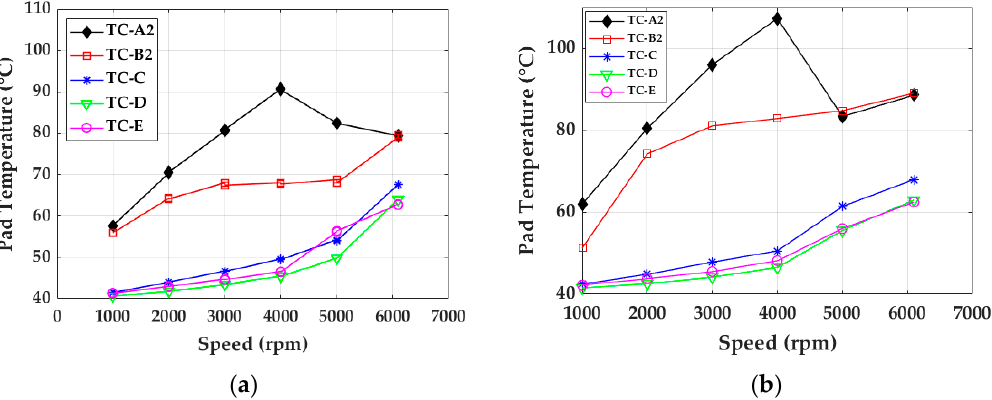
Figure 18. Flooded Rocker Pivot bearing pad temperatures @ 75% of pad arc: ( a ) 1.3 MPa, ( b ) 2.1 MPa.